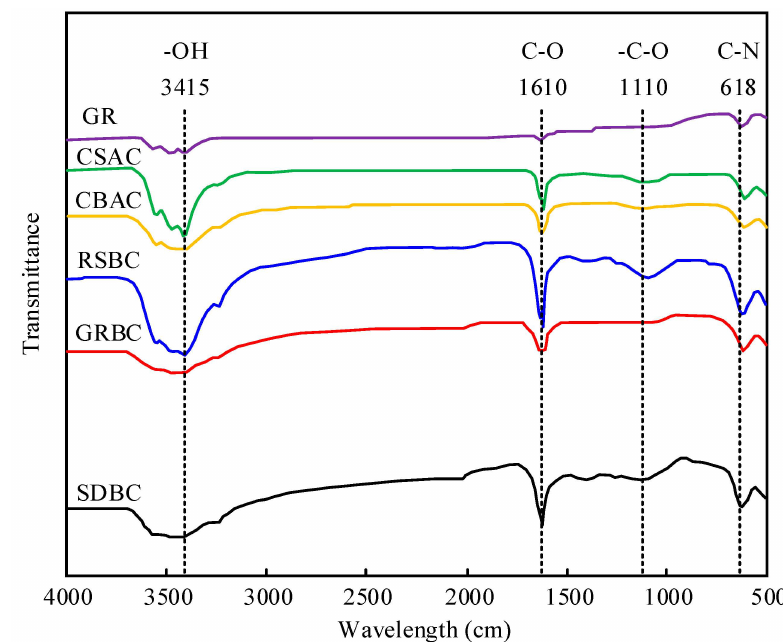
Figure 1. Characterized biochars FTIR spectra of